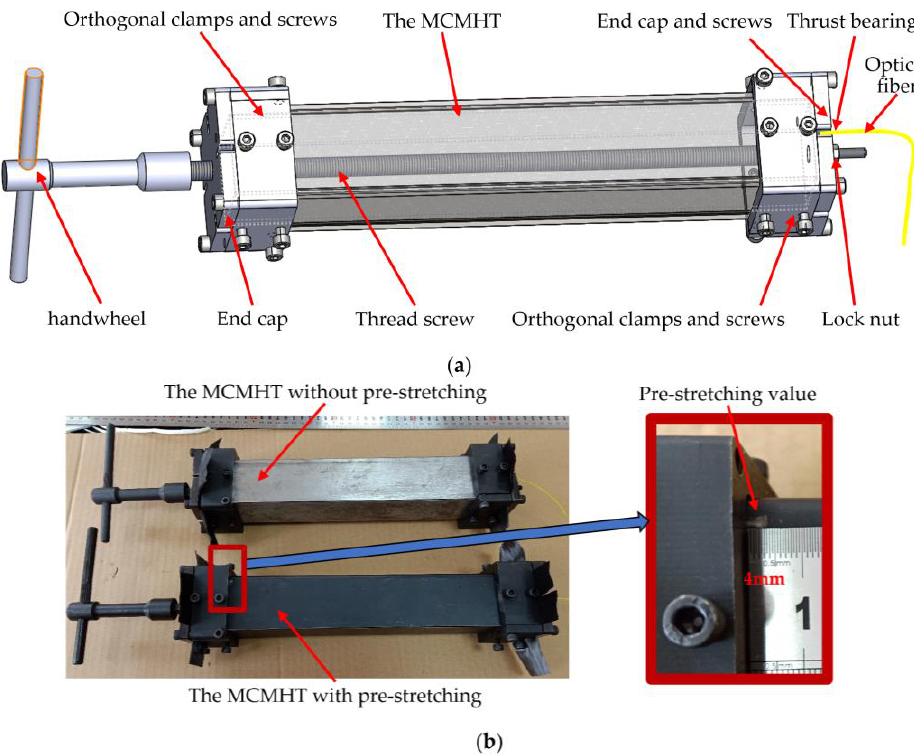
Figure 2. Structure of the MCMHT with the axial preload tool: ( a ) assembly schematic; ( b ) real fabricated MCMHTs.